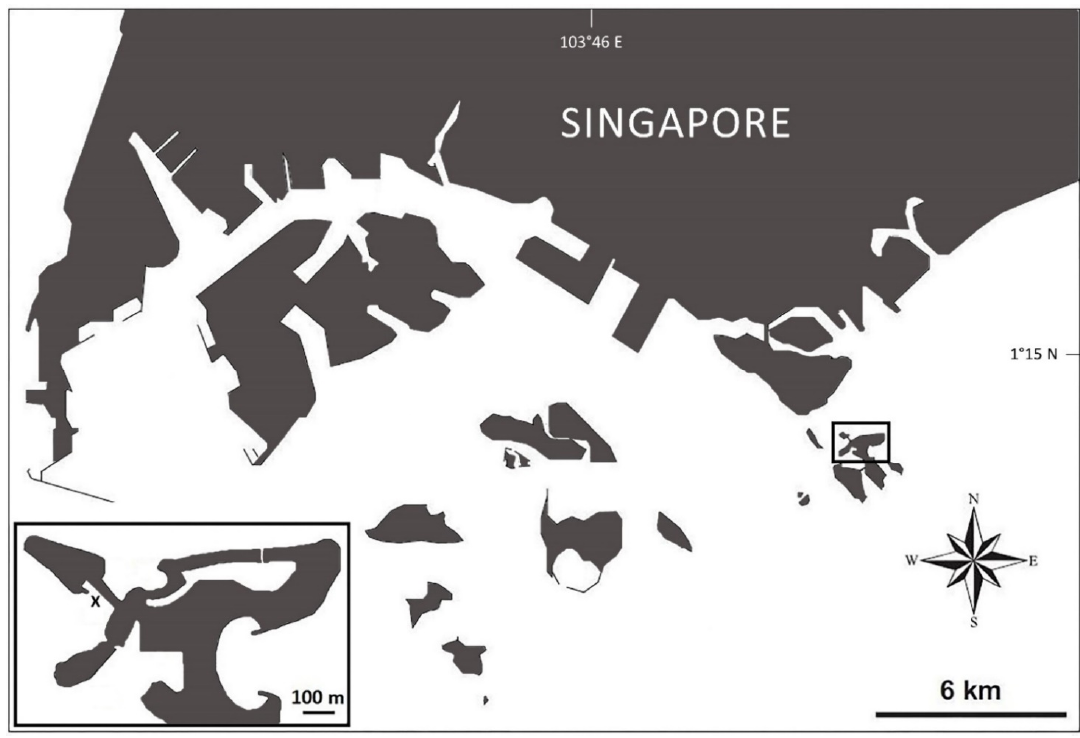
Figure 1. Map of mainland Singapore with the study site (marked “x”) located at Lazarus Island (inset).